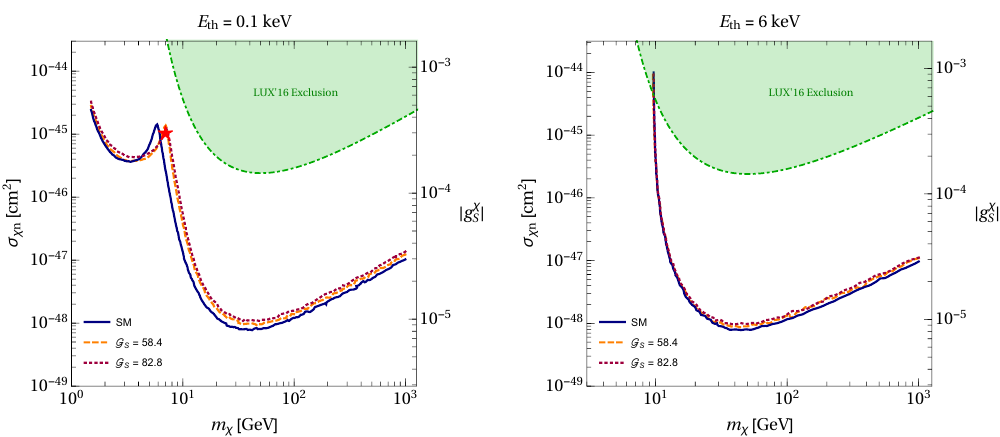
Figure 5 . As (cid:12)gure 4, but for the scalar mediator case. The SM neutrino (cid:13)oor (dark blue) is shown, along with two cases still allowed by the scalar model ( G S = 58 : 4, orange; G S = 82 : 8,